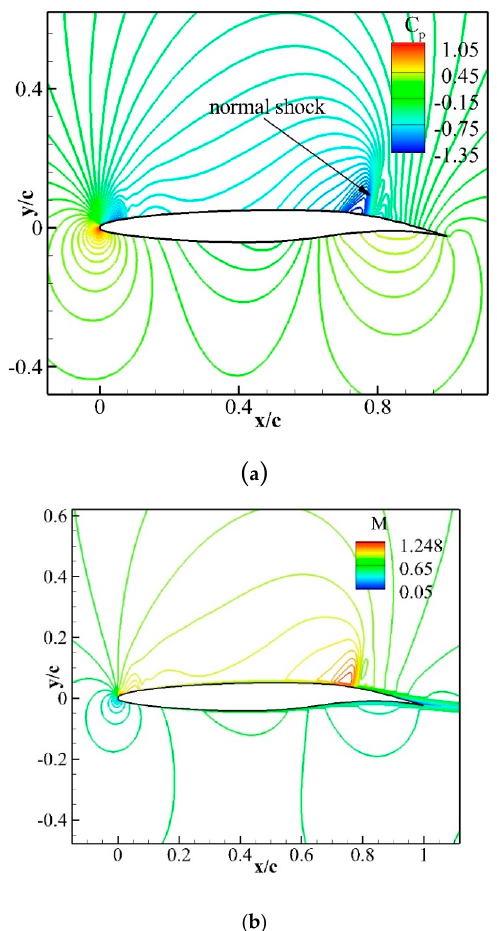
Figure 18. Computed ( a ) coefficient of pressure and ( b ) Mach contours for flow over the VCCTEF 321 airfoil at a zero angle of attack.